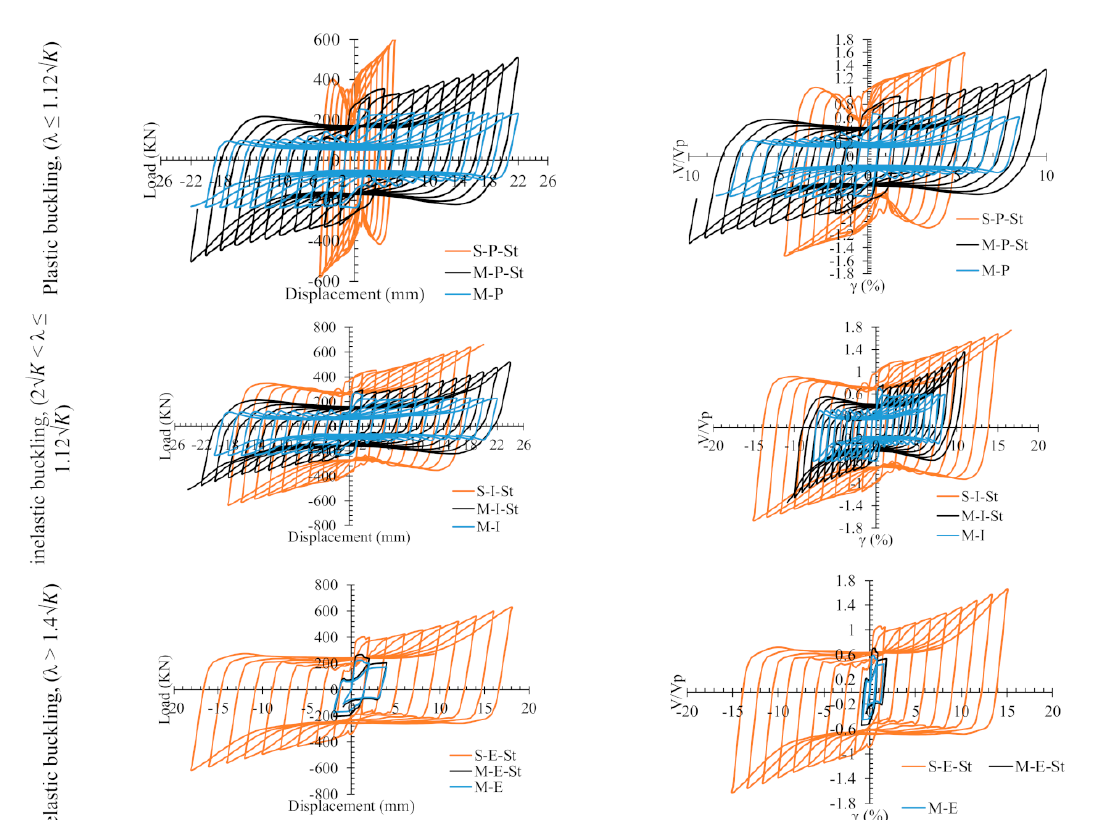
Figure 14. Hysteresis curves of FE